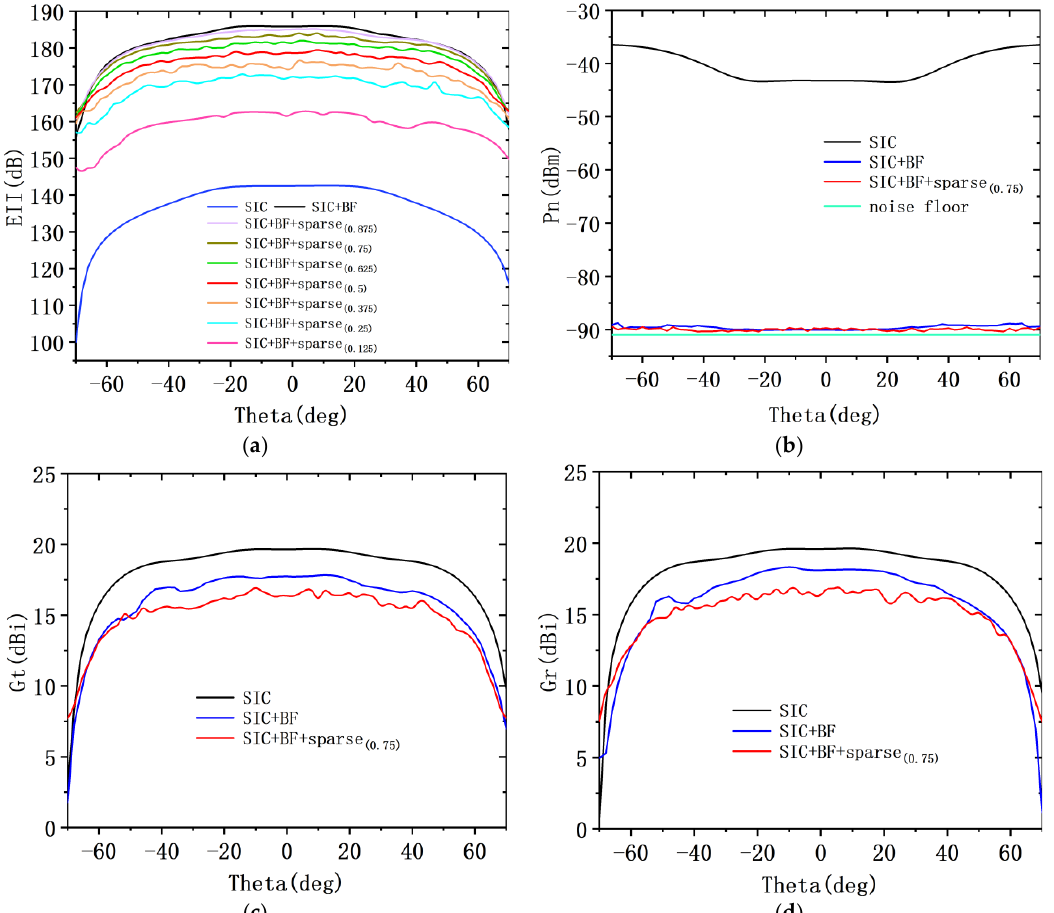
Figure 4. Comparison of performance indicators of the system under sparse arrays: ( a ) The EII at different sparsity rates; ( b ) P n curves in SIC, SIC-BF, and SIC-BF-spare with the sparsity rate of 0.75; ( c ) G t curves in SIC, SIC-BF, and SIC-BF-sparse arrays with the sparsity rate of 0.75; ( d ) G r curves in SIC, SIC-BF, and SIC-BF-sparse arrays with the sparsity rate of 0.75.